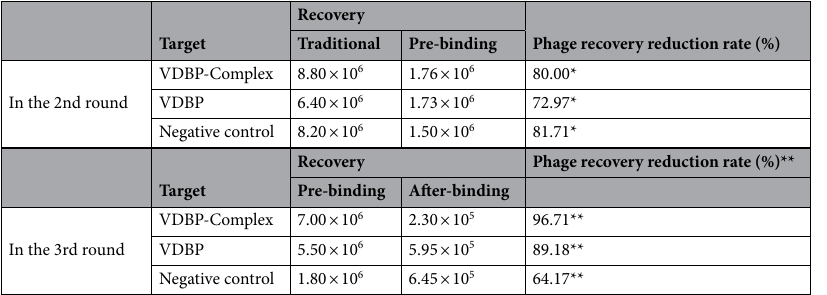
Table 2. Comparison of the recovery amount of each round when using each phage display method (recovery unit: pfu/mL). *Comparison of the phage recovery amount in the 2nd round when using traditional phage display and pre-binding phage display. The decrease rate of phage recovery amount in the 2nd round when using pre-binding phage display compared to traditional phage display is shown on the right side of the table. When the output pfu/mL of phage (recovery) is set to 100% in the traditional method, it is the value expressed in percent (%) for the recovery reduced in the pre-binding method. **Comparison of the phage recovery amount in the 3rd round when using the pre-binding phage display and after-binding phage display. The decrease rate of phage recovery amount in the 3rd round when using the after-binding phage display compared to the pre-binding phage display is shown on the right side of the table. When the output pfu/mL of phage (recovery) is set to 100% in the pre-binding method, it is the value expressed in percent (%) for the recovery reduced in the after-binding method. VDBP-Complex Vitamin D binding protein complex, VDBP Vitamin D binding protein, Negative control empty petri dish